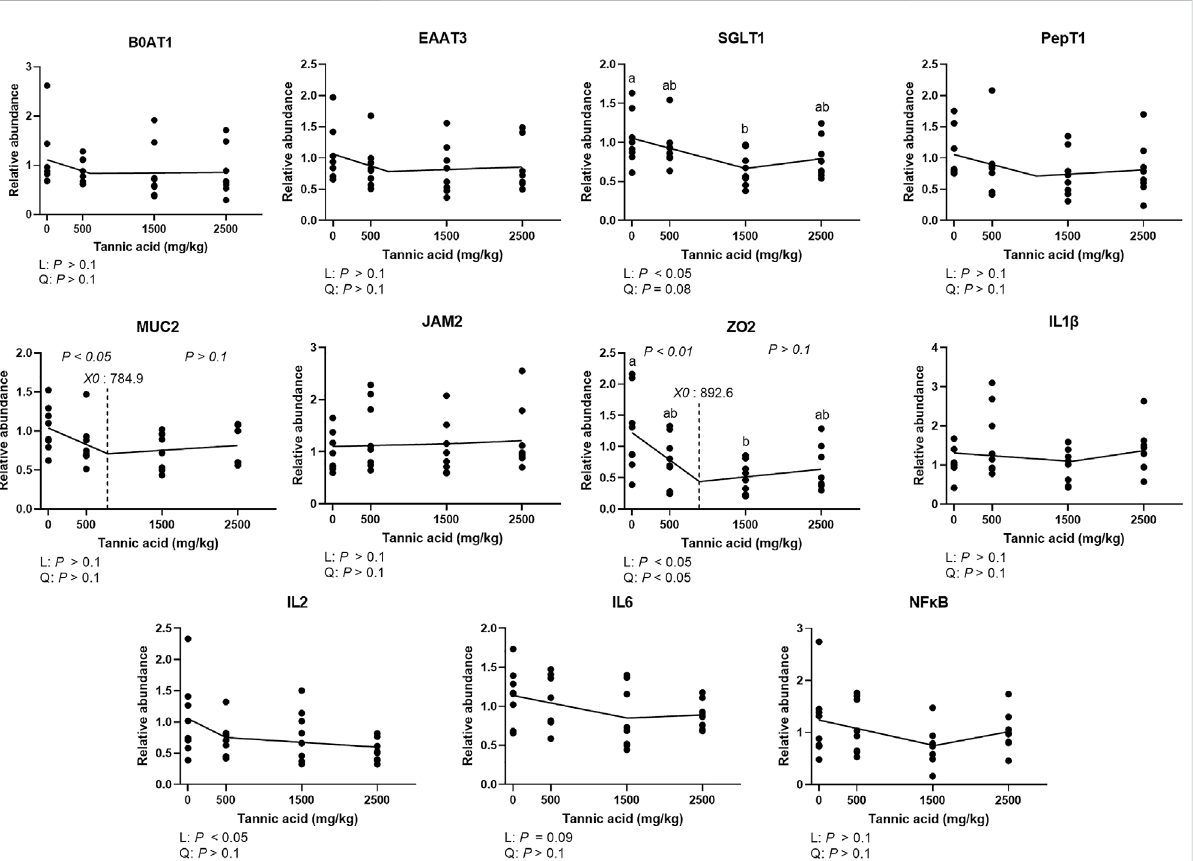
FIGURE 5 Relative mRNA expression of genes associated with nutrient transportation, gut barrier integrity, and in fl ammation in the jejunum in broiler chickens fed different concentrations (0, 0.5, 1.5, and 2.5 g/kg) oftannic acid on D 21. The treatment groups were compared using one-way ANOVA followed by the Tukey ’ s multiple comparison. Different superscripts differ at p < 0.05. Orthogonal polynomial contrasts analysis was conducted to see linear pattern (L) and quadratic pattern (Q) among the treatments. To calculate the optimal dosage of tannic acid in broilers, segmented linear regression was conducted, and X0 (in fl ection point) with p values for slope 1 (lower than X0 ) and slope 2 (higher than X0 ) were presented. B0AT1, sodium-dependent neutral amino acid transporter 1; EAAT3, excitatory amino acid transporter 3; SGLT1, sodium glucose transporter 1; PepT1,peptidetransporter1;MUC2,mucin2;JAM2,Junctionaladhesionmolecule2;Zonulaoccludens2;zonulaoccludens2;IL,interleukin;NF κ B, nuclear factor kappa-light-chain-enhancer of activated B